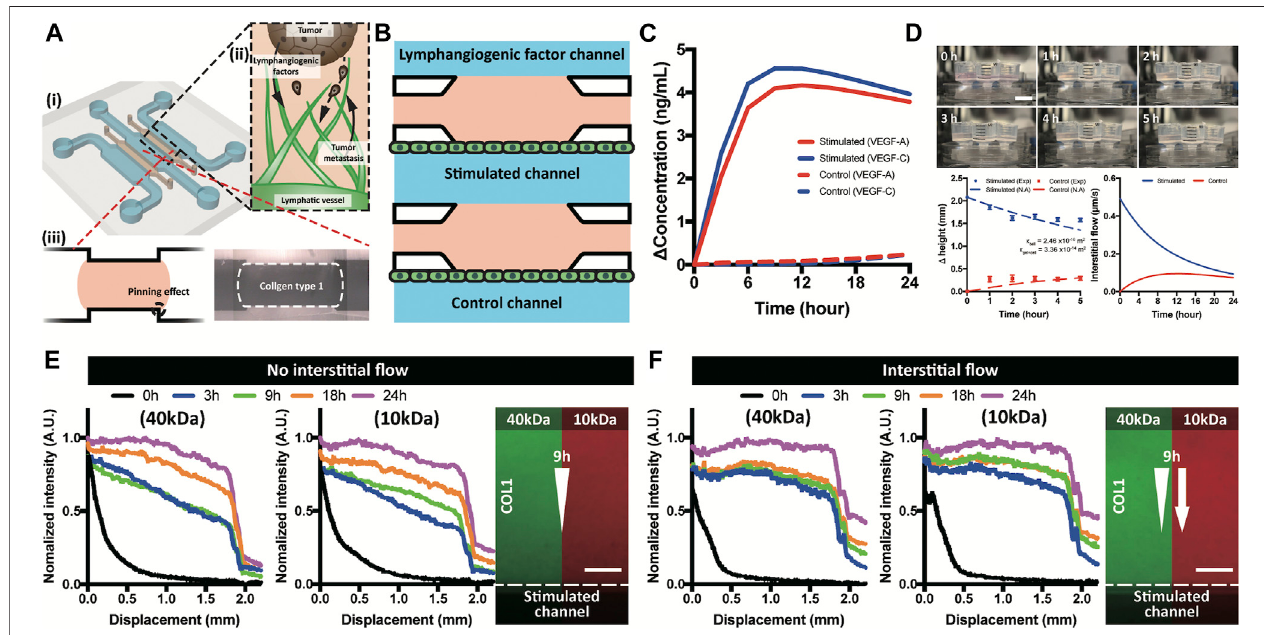
FIGURE1| Briefillustrationofamacro fl uidicdeviceandmoleculardistribution. (A) ECMincorporatedmacro fl uidicdeviceandillustrationoflymphangiogenesisina tumor microenvironment. (B) Top view of the macro fl uidic device. (C) Generated growth factor gradient on the lymphatic endothelium in a stimulated and control channel. (D) Interstitial fl owgenerationusing hydraulichead differenceand anumericalanalysis. (E,F) Experimental con fi rmation ofmolecular distribution in COL1under absence and applied interstitial fl ow. Scale bar is 200 μ m.